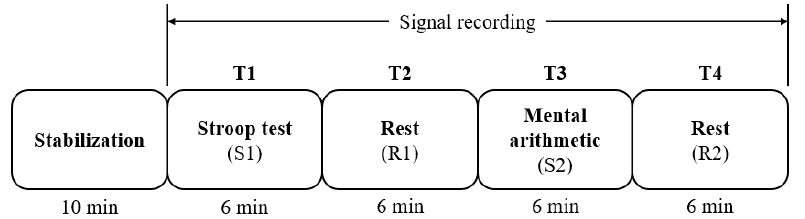
Figure 4. The stress test protocol employed herein.